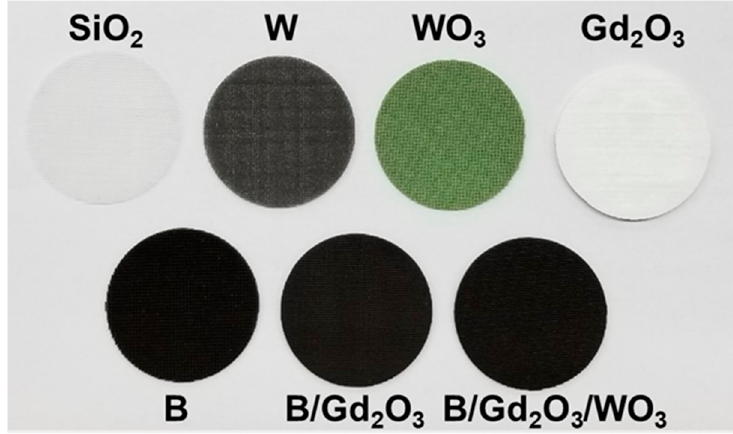
Figure 2. 3D-printed cylinders of the ink formulations detailed in this study.